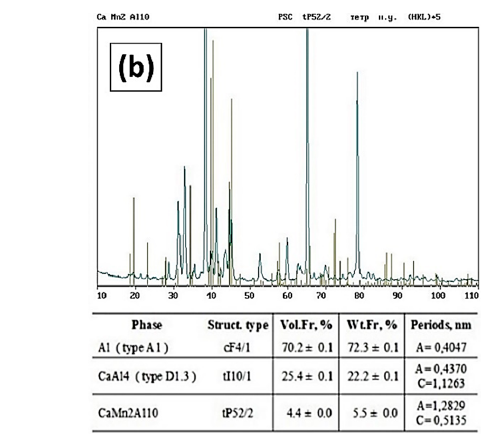
Figure 5. SEM images showing the Al 10 Mn 2 Ca crystals appeared in the Al-6Ca-3Mn alloy after furnace cooling ( a ) and X- ray analysis data identified the Al 10 Mn 2 Ca compound ( b ) .